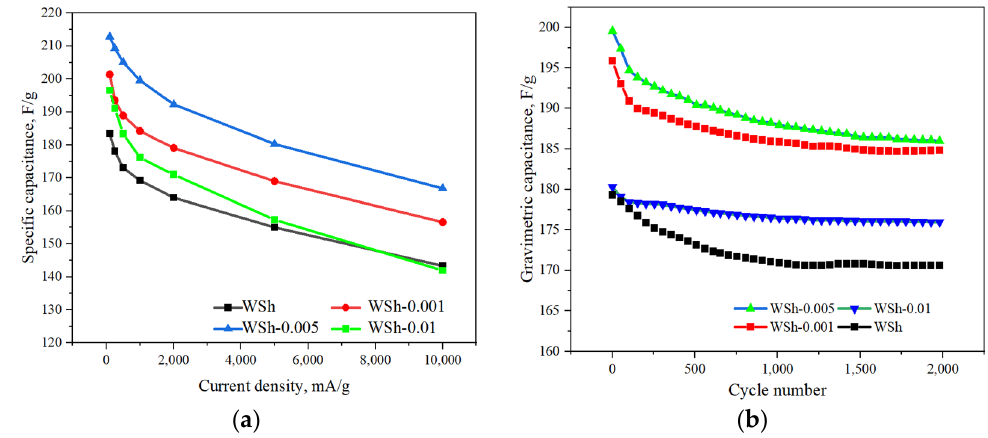
Figure 6. ( a ) — Specific capacitance of electrodes calculated from charge-discharge curves at various current densities; ( b ) — Specific capacitance versus physical cycle number performed at a constant current density of 1000 mA/g.